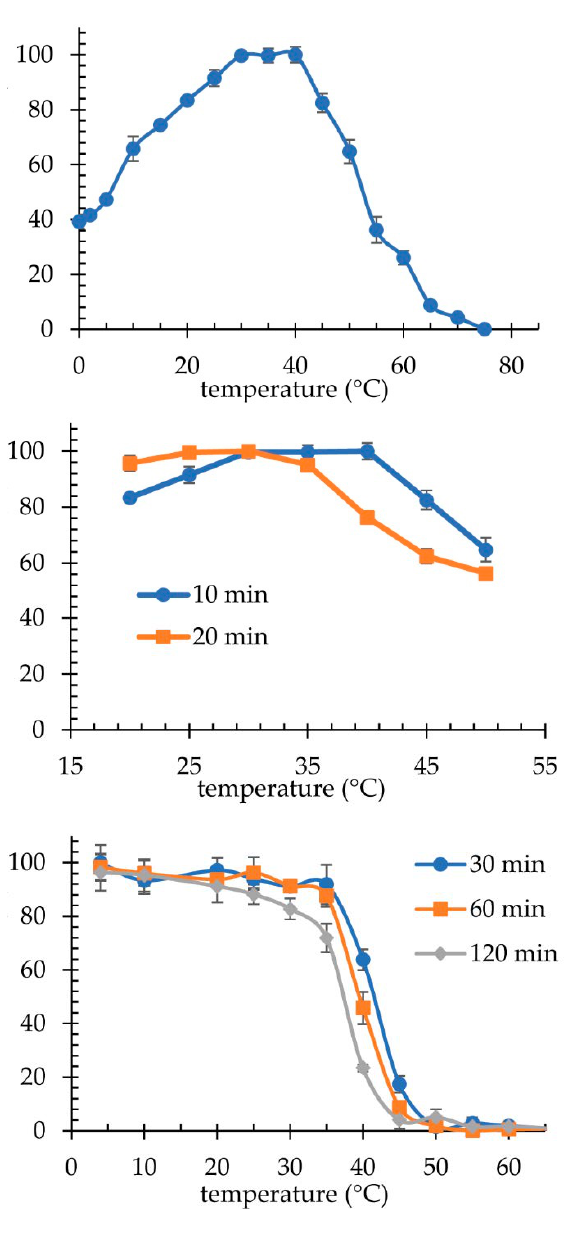
Figure 10. Properties of laccase K. bupleuri : optimal temperature ( upper panel ) and its variation for different reaction times ( middle panel ); thermostability during 30-, 60- and 120-min incubation ( lower panel ).